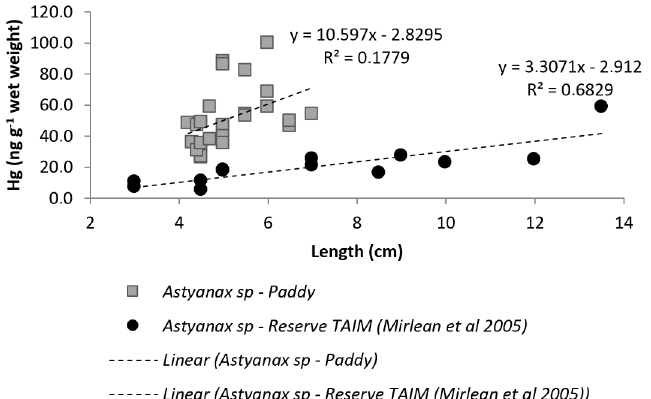
Figure 3. Mercury concentration in Astyanax sp from paddy in comparison to data from Mirlean et al. (2005) nature